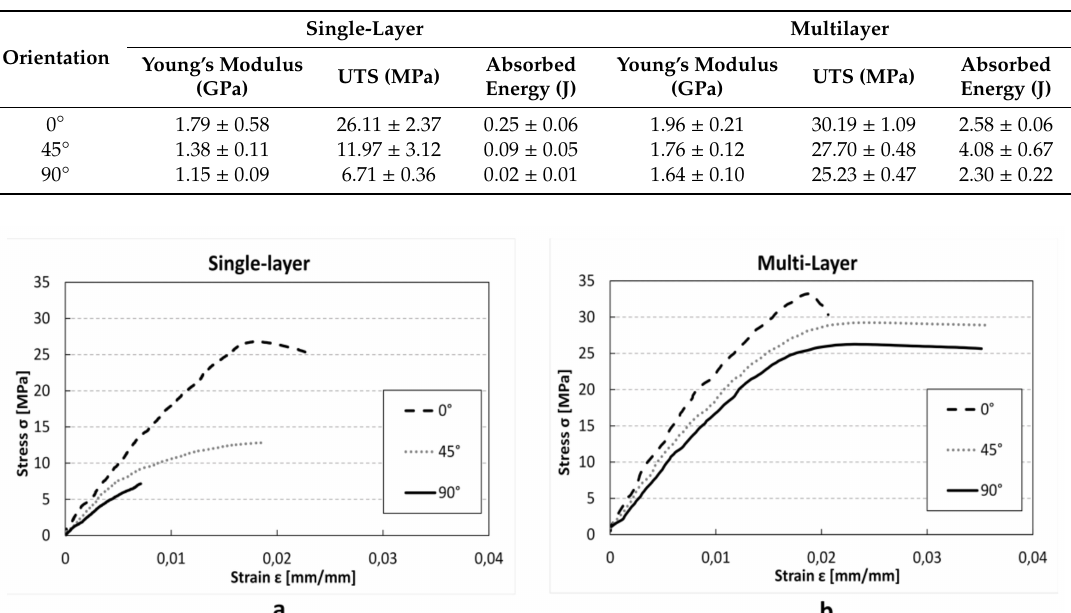
Table 4. Single- and multilayer mechanical properties at di ff erent raster angles.